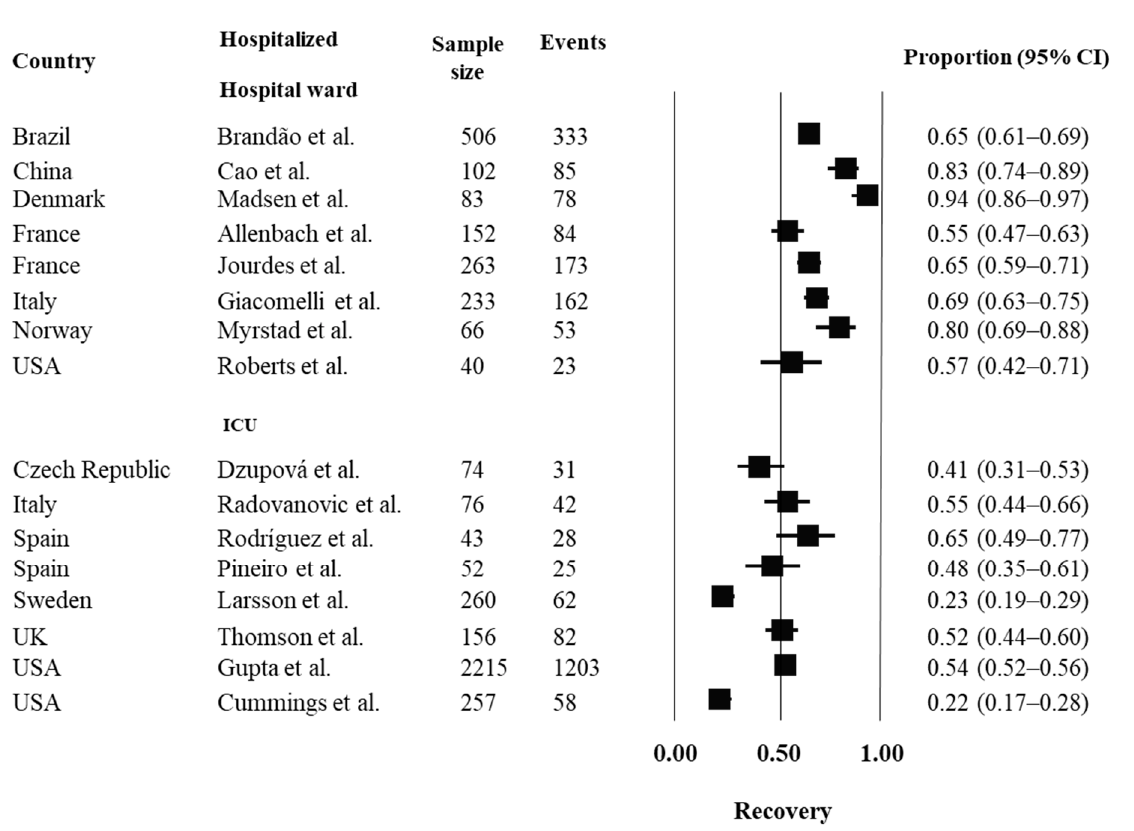
Figure 5. Prognosis of recovery in hospitalized people with COVID-19. For analysis, the studies were grouped by country and by hospital setting (hospital ward or ICU). Estimates of proportions for dichotomous data, considering the number of events and sample size, were reported. Abbreviations: ARDS = acute respiratory distress syndrome; USA = United States of America; UK = United Kingdom; IC = confidence interval. References: Brandão et al. [14]; Cao et al. [15]; Madsen et al. [17]; Allenbach et al. [20]; Jourdes et al. [18]; Giacomelli et al. [21]; Myrstad et al. [24]; Roberts et al. [27]; Dzupová et al. [28]; Radovanovic et al. [31]; Rodríguez et al. [35]; Pineiro et al. [36]; Larsson et al.